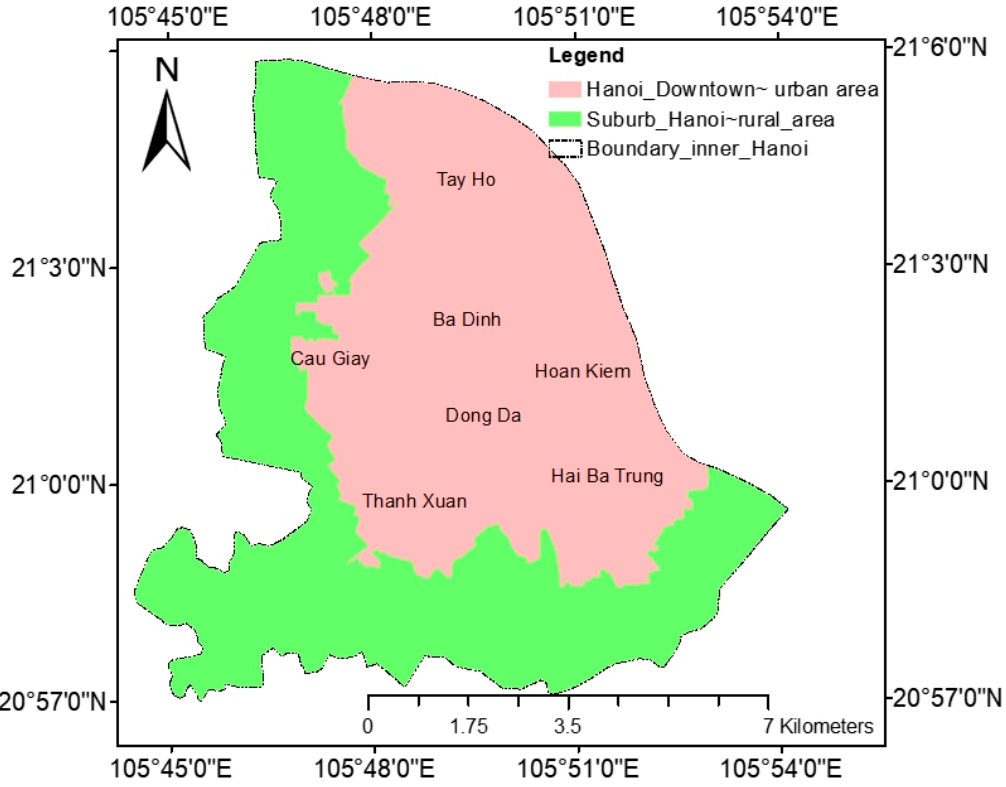
Figure 7. The map shows downtown of inner Hanoi (pink color) and suburban (green color). Table 8. LSTs of urban and suburban areas of inner Hanoi. STD stands for standard deviation.